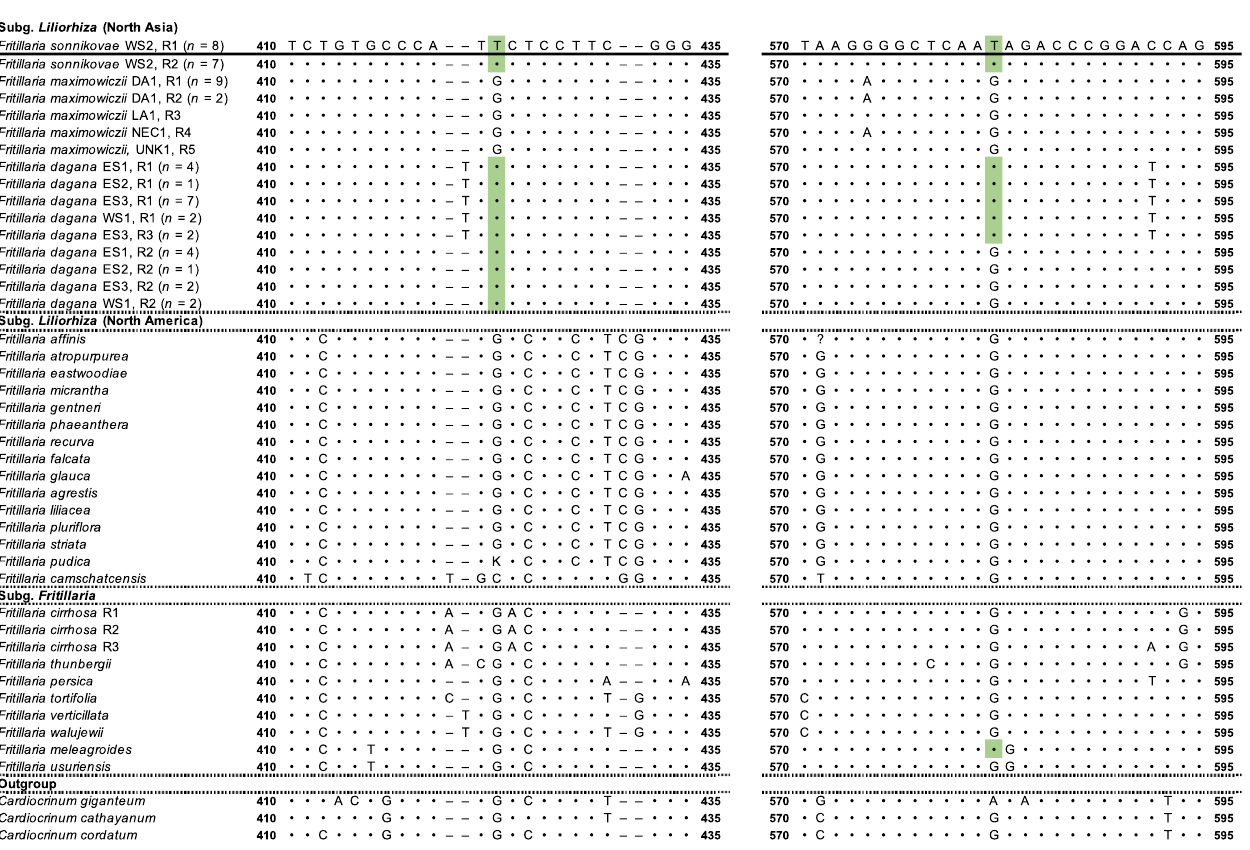
Figure 3. Two parts of the multiple alignment of the ITS2 region. The number of haplotype copies found by molecular cloning is indicated in brackets. The dots indicate the bases, the same as in the reference sequence ( F. sonnikovae , R1), the characters indicate the different bases, the dashes indicate the gaps, and the numbers indicate positions in the multiple alignment. The possible synapomorphies shared by F. sonnikovae and F. dagana/F. meleagroides are shown in light green.